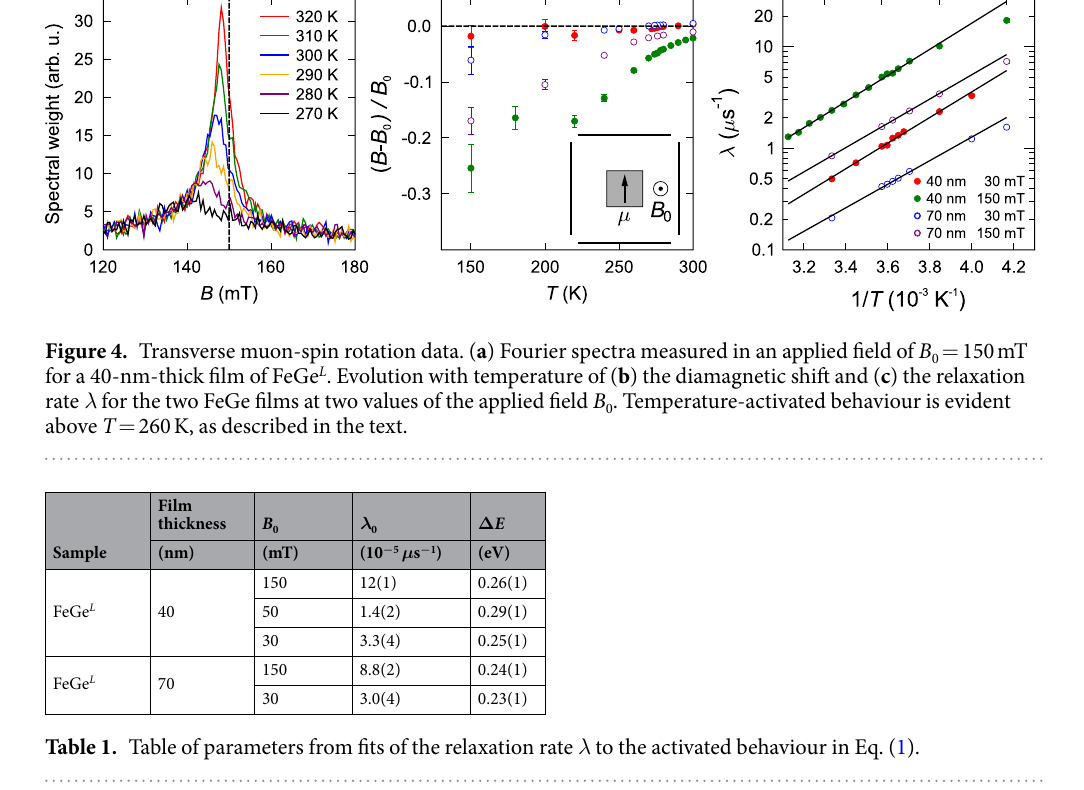
Table 1. Table of parameters from fits of the relaxation rate λ to the activated behaviour in Eq.